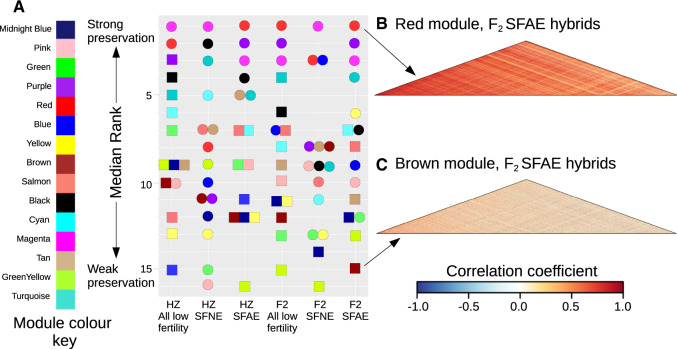
Preservation of the fertile consensus network within subfertile hybrids classified according to mapping population derived and expression profile (SFNE or SFAE, see fig. 1). (A) Module preservation estimated using median rank statistics. Color indicates module identity. Circles represent significantly preserved modules, and squares represent modules not significantly preserved. (B and C) Coexpression heatmaps for examples of well-preserved (Red) and poorly preserved (Brown) modules. Heatmaps show pairwise correlations between expression values for all genes within modules for SFAE F2 hybrids.